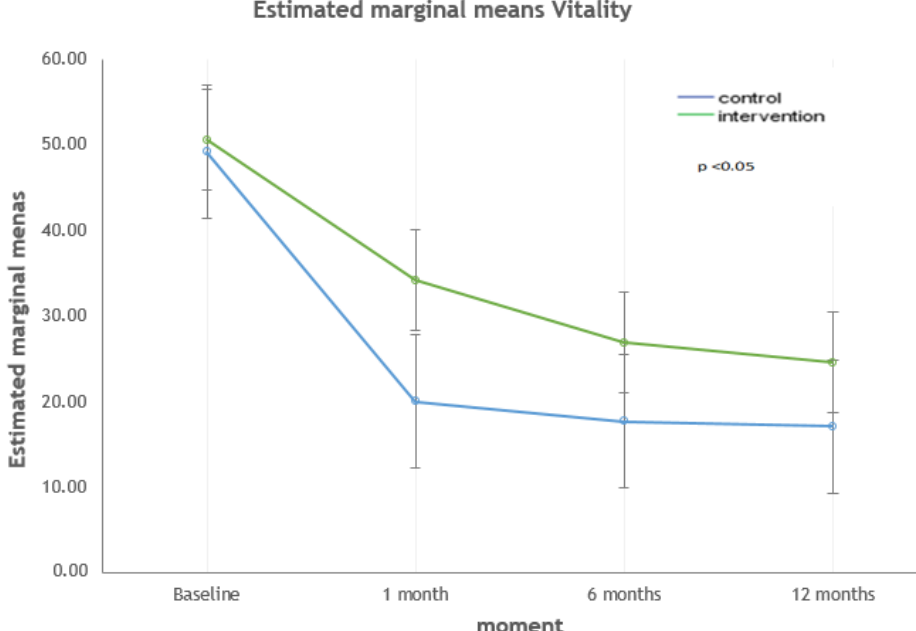
Figure 3. Evolution of the vitality dimension: intervention vs. control group.